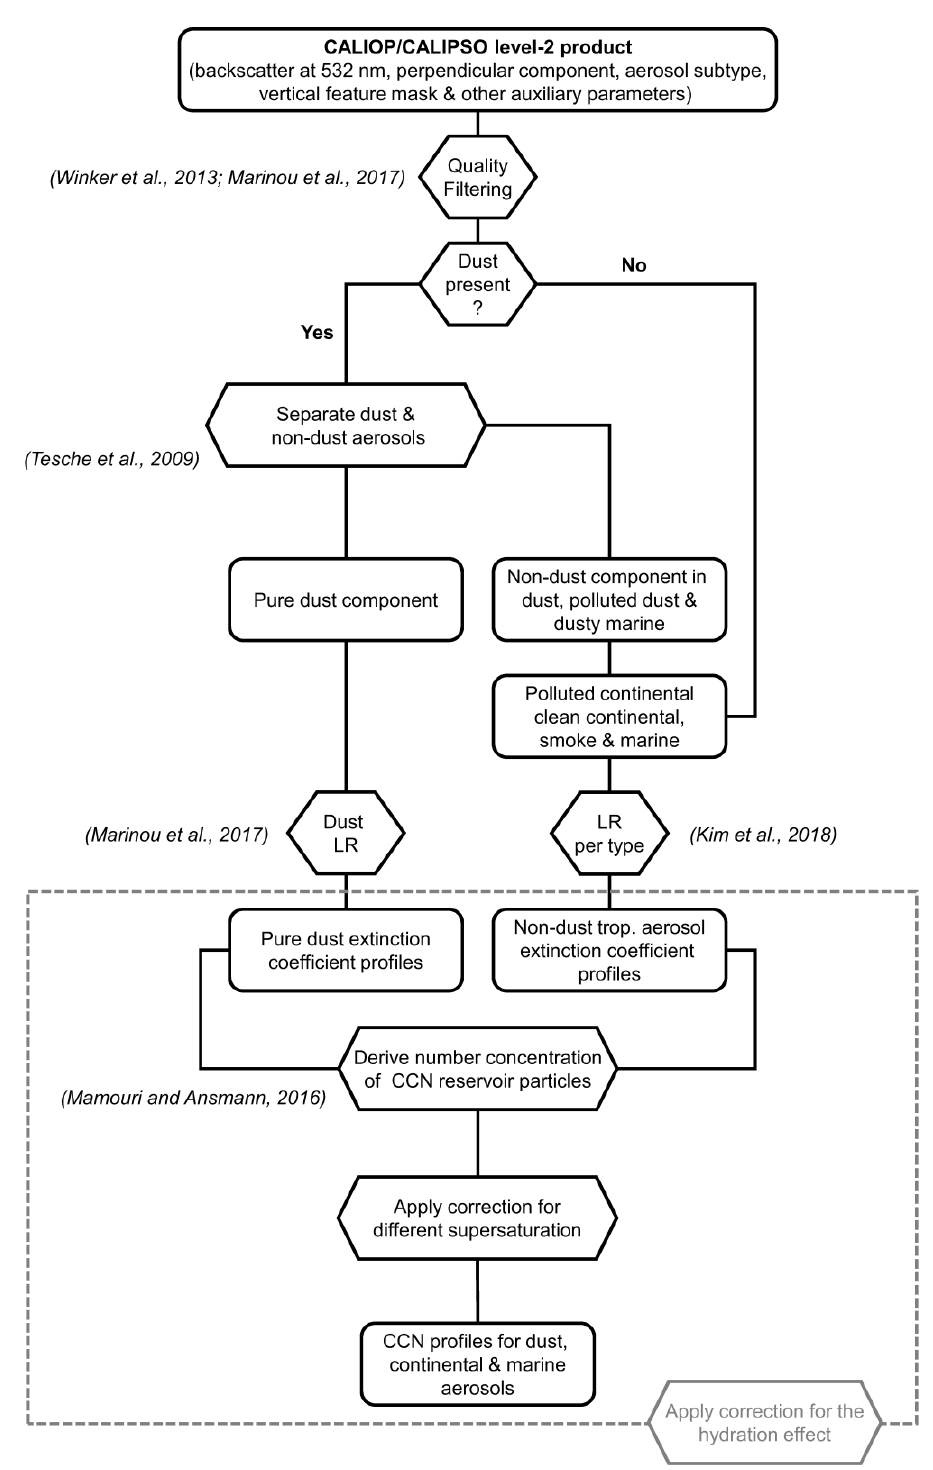
Figure 1. Methodology for the retrieval of cloud condensation nuclei (CCN) concentrations from Cloud-Aerosol Lidar and Infrared Pathfinder Satellite Observations (CALIPSO) measurements of different aerosol types.